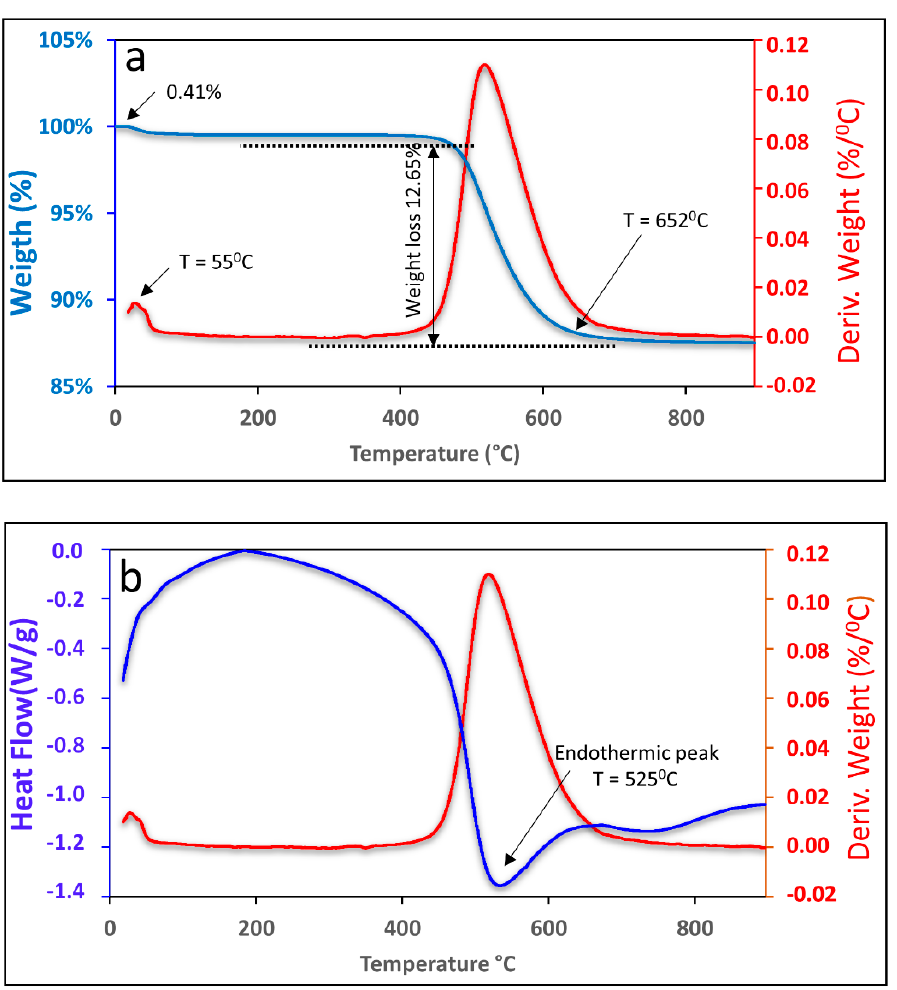
Figure 1. TGA ( a ) and DTA ( b ) curves of kaolin.